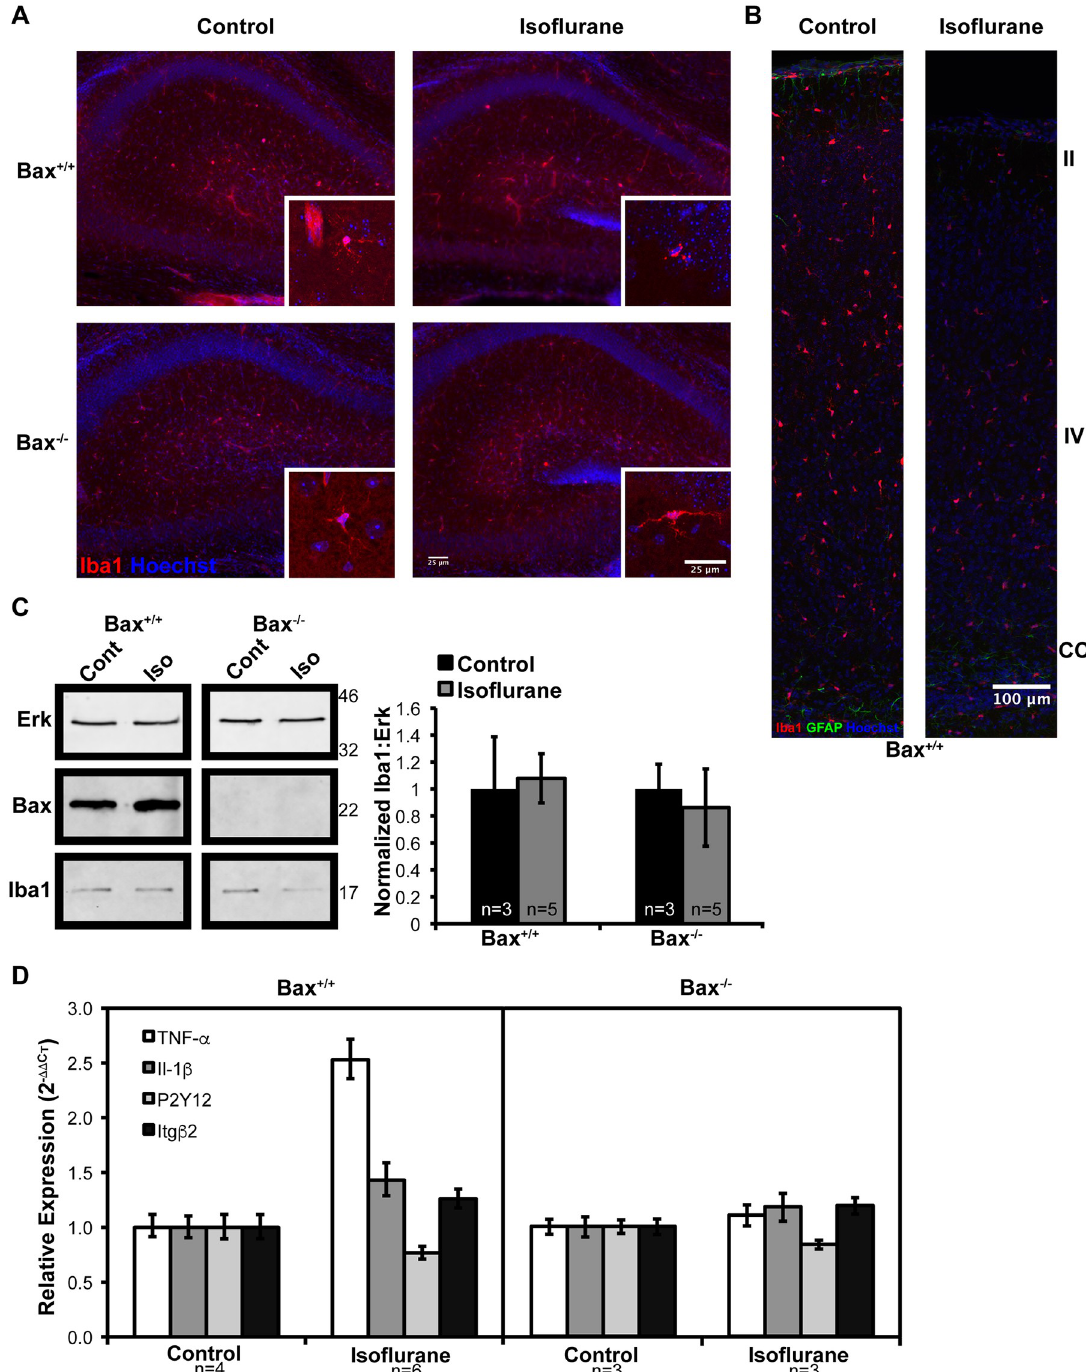
Fig 2. Neuroinflammation following exposure to isoflurane in the neonatal period is a consequence of neuron death. A) Low magnification images of hippocampal microglia and high magnification images taken in the molecular layer in the CA1 region (inset). B) Microglia imaged throughout the cortex. Approximate position of cortical layers II, IV and the corpus callosum (CC) are shown. C) Western blot analysis of Iba1 content in cortical lysate and quantification by band densitometry. D) RT-PCR analysis of the relative expression of microglia-derived proinflammatory cytokines and microglia activation genes, mean ± 95% confidence intervals are shown.